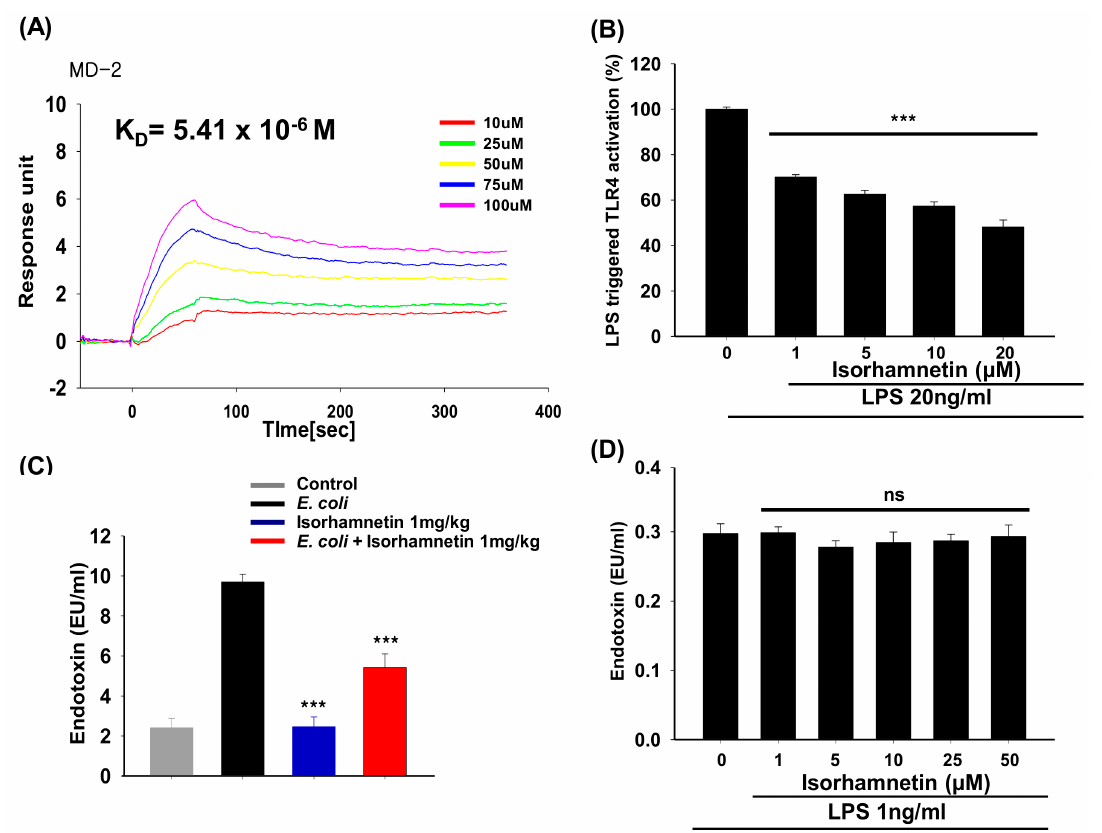
Figure 4. Effect of isorhamnetin on binding to MD-2, LPS-induced SEAP secretion and LPS neutralization ( A ) Surface plasmon resonance (SPR) analysis to determine the binding interaction. ( B ) Secretary alkaline phosphate (SEAP) assay in HEK-Blue™ hTLR4 cells (toll-like receptors (TLRs)). ( C ) Limulus amebocyte lysate (LAL) assay in serum of mice. ( D ) LAL assay to detect LPS